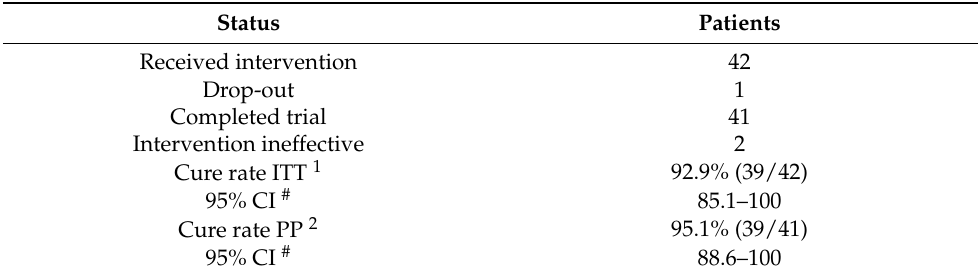
Table 3. Intervention status of patients enrolled in the study.